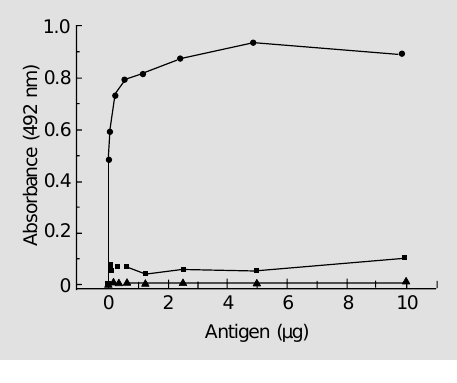
Figure 2 - Titration of goat anti- rabbit IgG conjugated with horseradish peroxidase by ELISA using paper filter plasti- cized with polyvinyl alcohol-glu- taraldehyde as solid phase. The conjugate was diluted from 1:1,500 to 1:24,000 in PBS and ELISA was carried out using 1.25 µg antigen/disc and 100 µl of immunized serum diluted 1:6,400 (circles), non-immunized serum (squares) and PBS (tri-